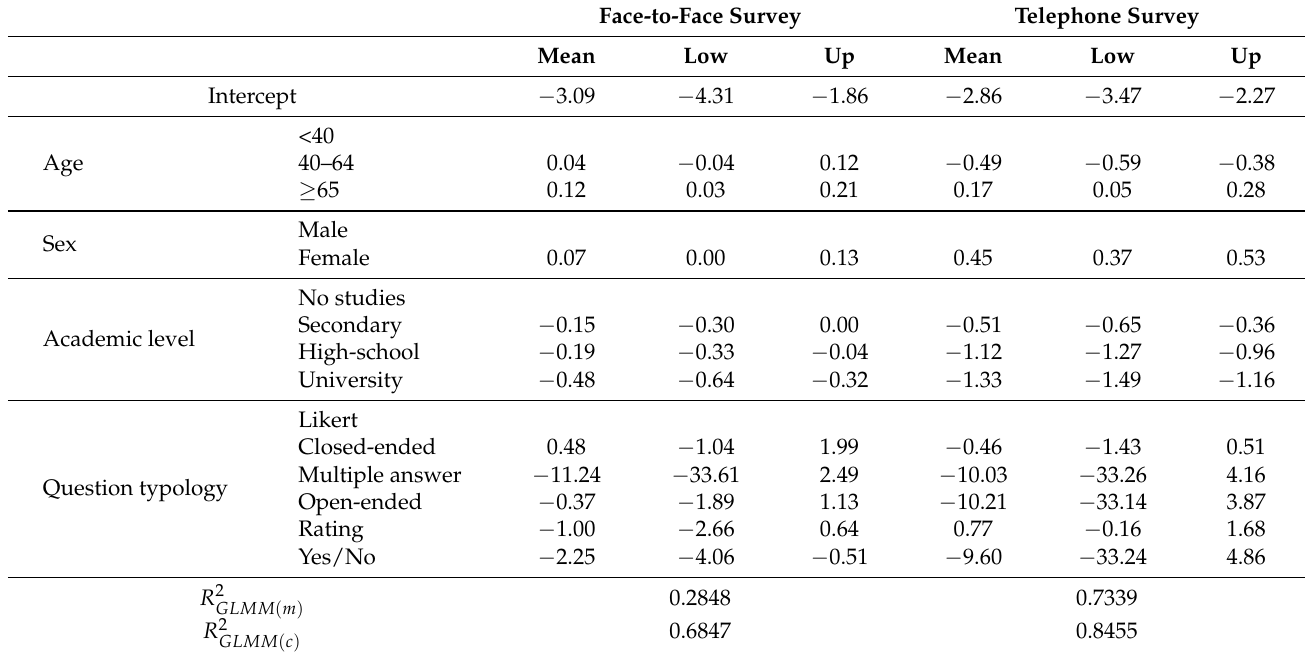
Table 3. Fixed-effect estimates corresponding to the modeling of the item non-response values, following Equation (2), in terms of the mean of the posterior distribution of each parameter involved. The lower (Low) and upper (Up) bounds of the 95% credibility interval associated with each estimate are also provided.